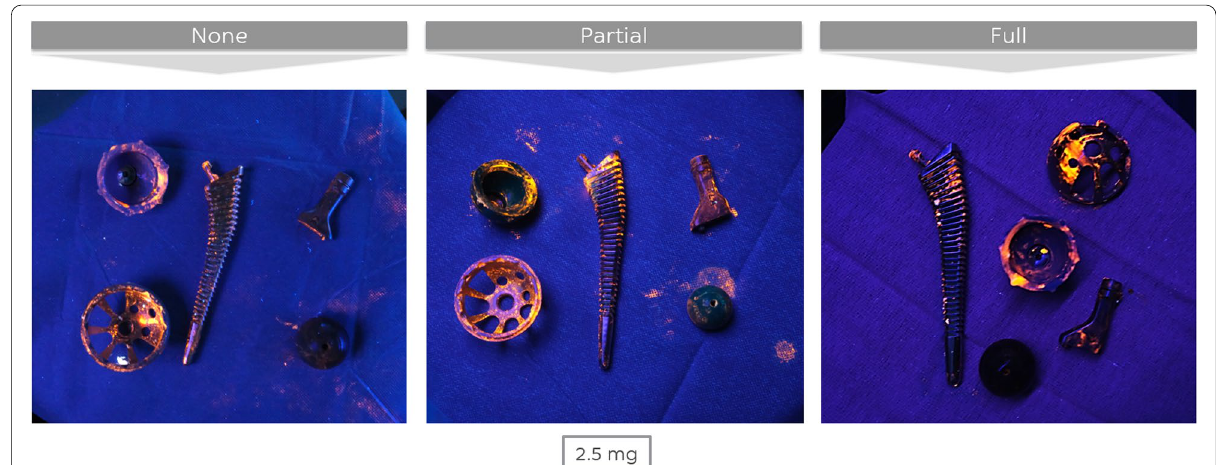
Fig. 8 The newly implanted THA at the end of the one-step exchange for three different clean phase protocols (bacterial load 3 GloGerm